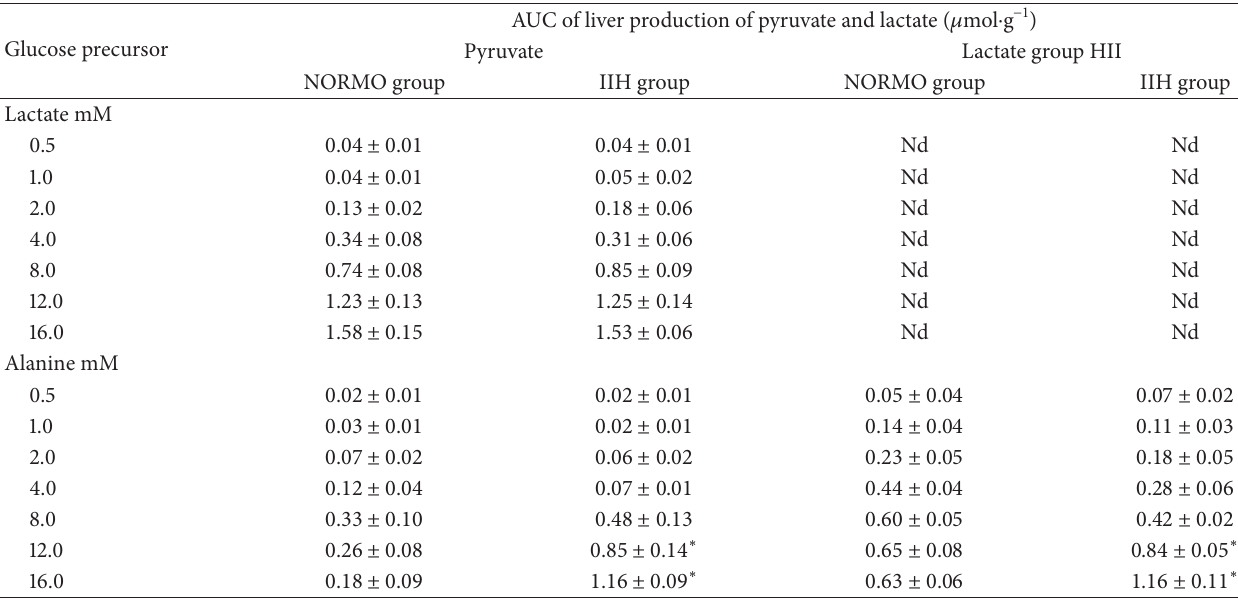
Table 1: Liver production of pyruvate from increasing concentrations (mM) of lactate and liver production of pyruvate or lactate from increasing concentrations (mM) of alanine in fasted mice. The animals were subjected to in situ liver perfusion 180min after an intraperitoneal injectionofregularinsulin(1.0 U ⋅ kg − 1 ,IIHgroup)orsaline(NORMOgroup).Theareasundercurve(AUCs),thatis,theincrementofpyruvate and L-lactate production between 10 and 110min were calculated as described in Section